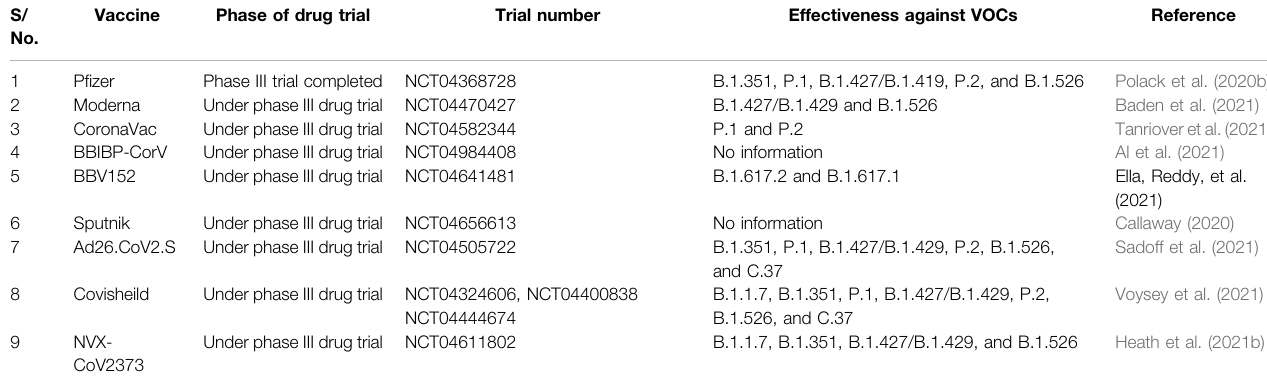
TABLE 1 | Trial stages of some important COVID-19 vaccines and their ef fi cacy with respect to different SARS-CoV-2 variants S/